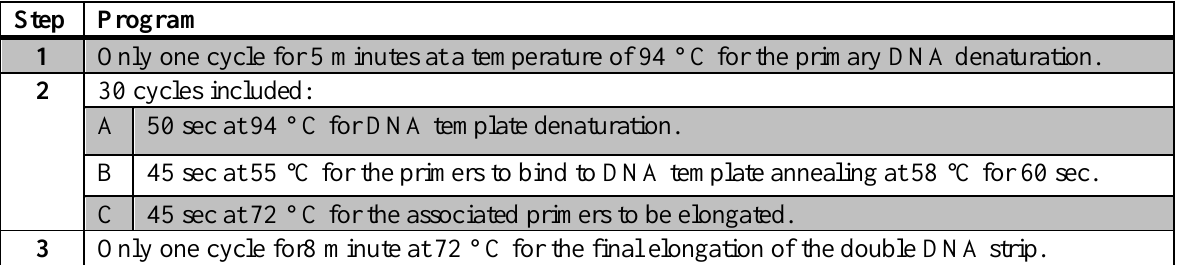
Table (3): Optimal conditions of PCR reaction for determination of cvaC